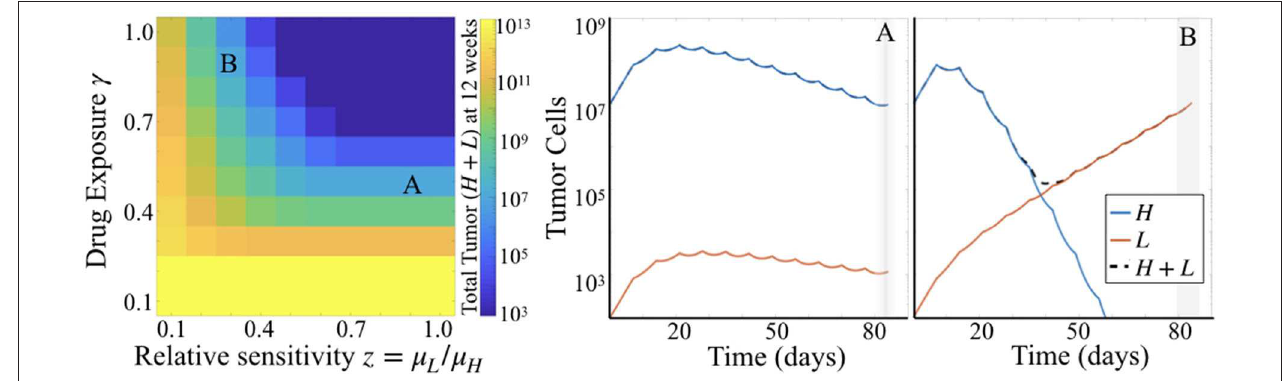
FIGURE 5 | Simulation results for varied γ and z . (Left) Heatmap shows total tumor cells at 84 days (12 weeks) post tumor initiation, across 10 values each of γ and z , for fixed µ H = 5. (Right) Two particular simulations corresponding to the labels (A,B) in the